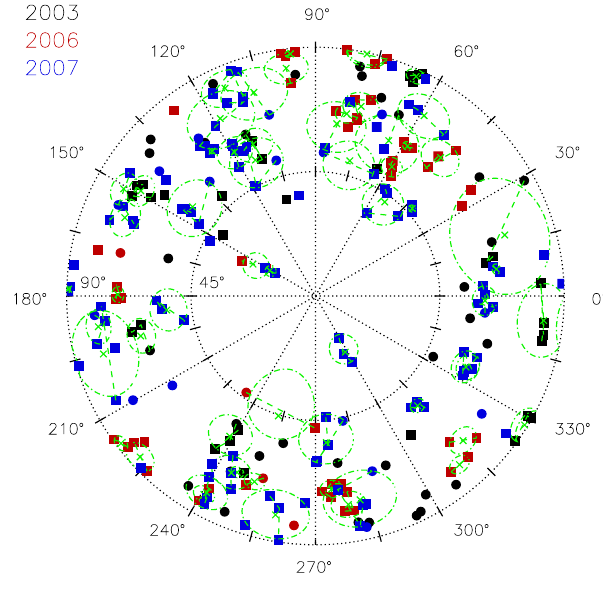
Fig. 4. Polar plot of the direction of the normal vectors of TDs. The azimuthal angle is measured between the GSE y direction and the projection of the normal vector onto the GSE yz plane. The distance from the center is the γ angle as determined by the cross-product method. The TD normal vector is in a special polar coordinate sys- tem in which we measure the γ angle from the center, and where the azimuth is the angle of GSE y and the projection of normal vector to GSE yz plane. The regions surrounded by dashed lines are the pro- jection of error cones around the average normal vector marked by “X”. Circles and squares symbolize ACE and Cluster data, respec- tively. The black, red and blue symbols present events observed in 2003, 2006 and 2007,